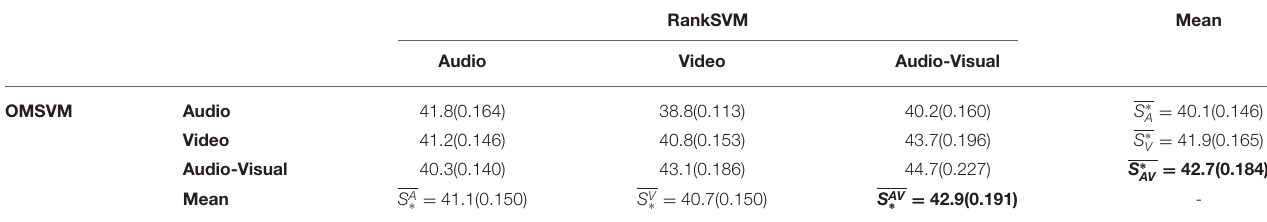
TABLE 5 | Performance of Valence prediction in terms of Unweighted Average Recall (UAR %) and weighted kappa k w (reported inside parenthesis).